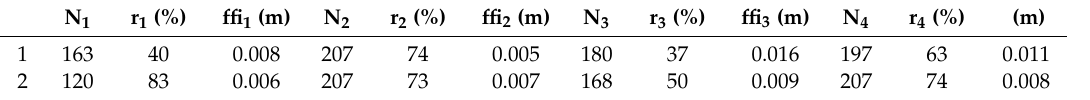
Table 9. Fitting residual comparison of principal legs in two situations.